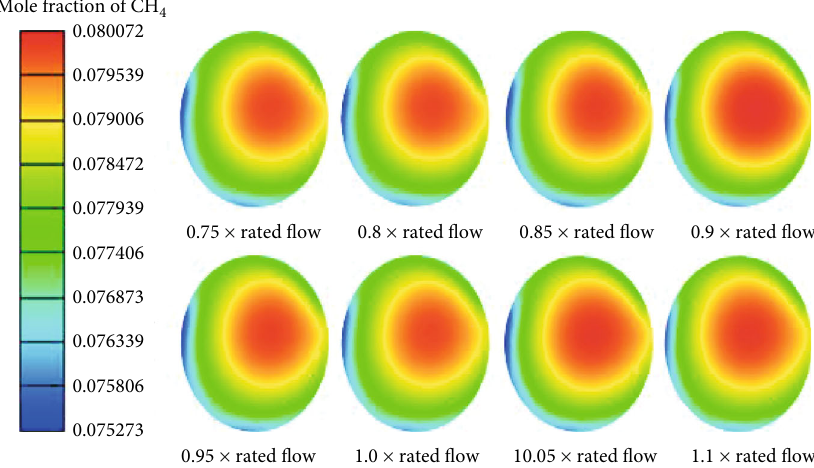
Figure 15: In fl uence of air mixture fl ow change on the uniformity of gas.